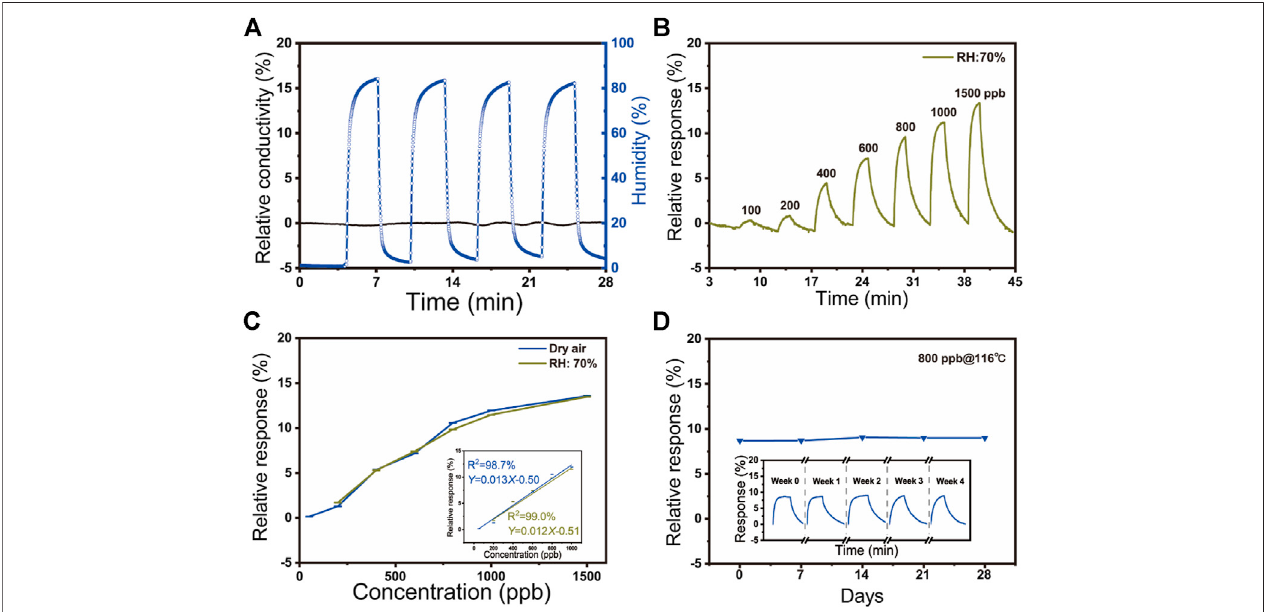
FIGURE 4 | (A) The relative response of sensors in high humidity in four cycles (83% RH); (B) The relative response to different concentrations of NO 2 (50 – 1500 ppb) under 70% RH environment at 116 ° C; (C) The relative response of the various NO 2 concentration to ambient humidity at 116 ° C; (c. inset) The linear fi t between the concentration of NO 2 and dynamic response under dry air (blue) and 70% RH (green) at 116 ° C; (D) Long time stability of SnO 2 /rGO composite-based sensors to 800 ppb NO 2 at room temperature for about 28 days; (d. inset) The repeatability of sensors to 800 ppb NO 2 during the fi ve testing cycles at 116 °